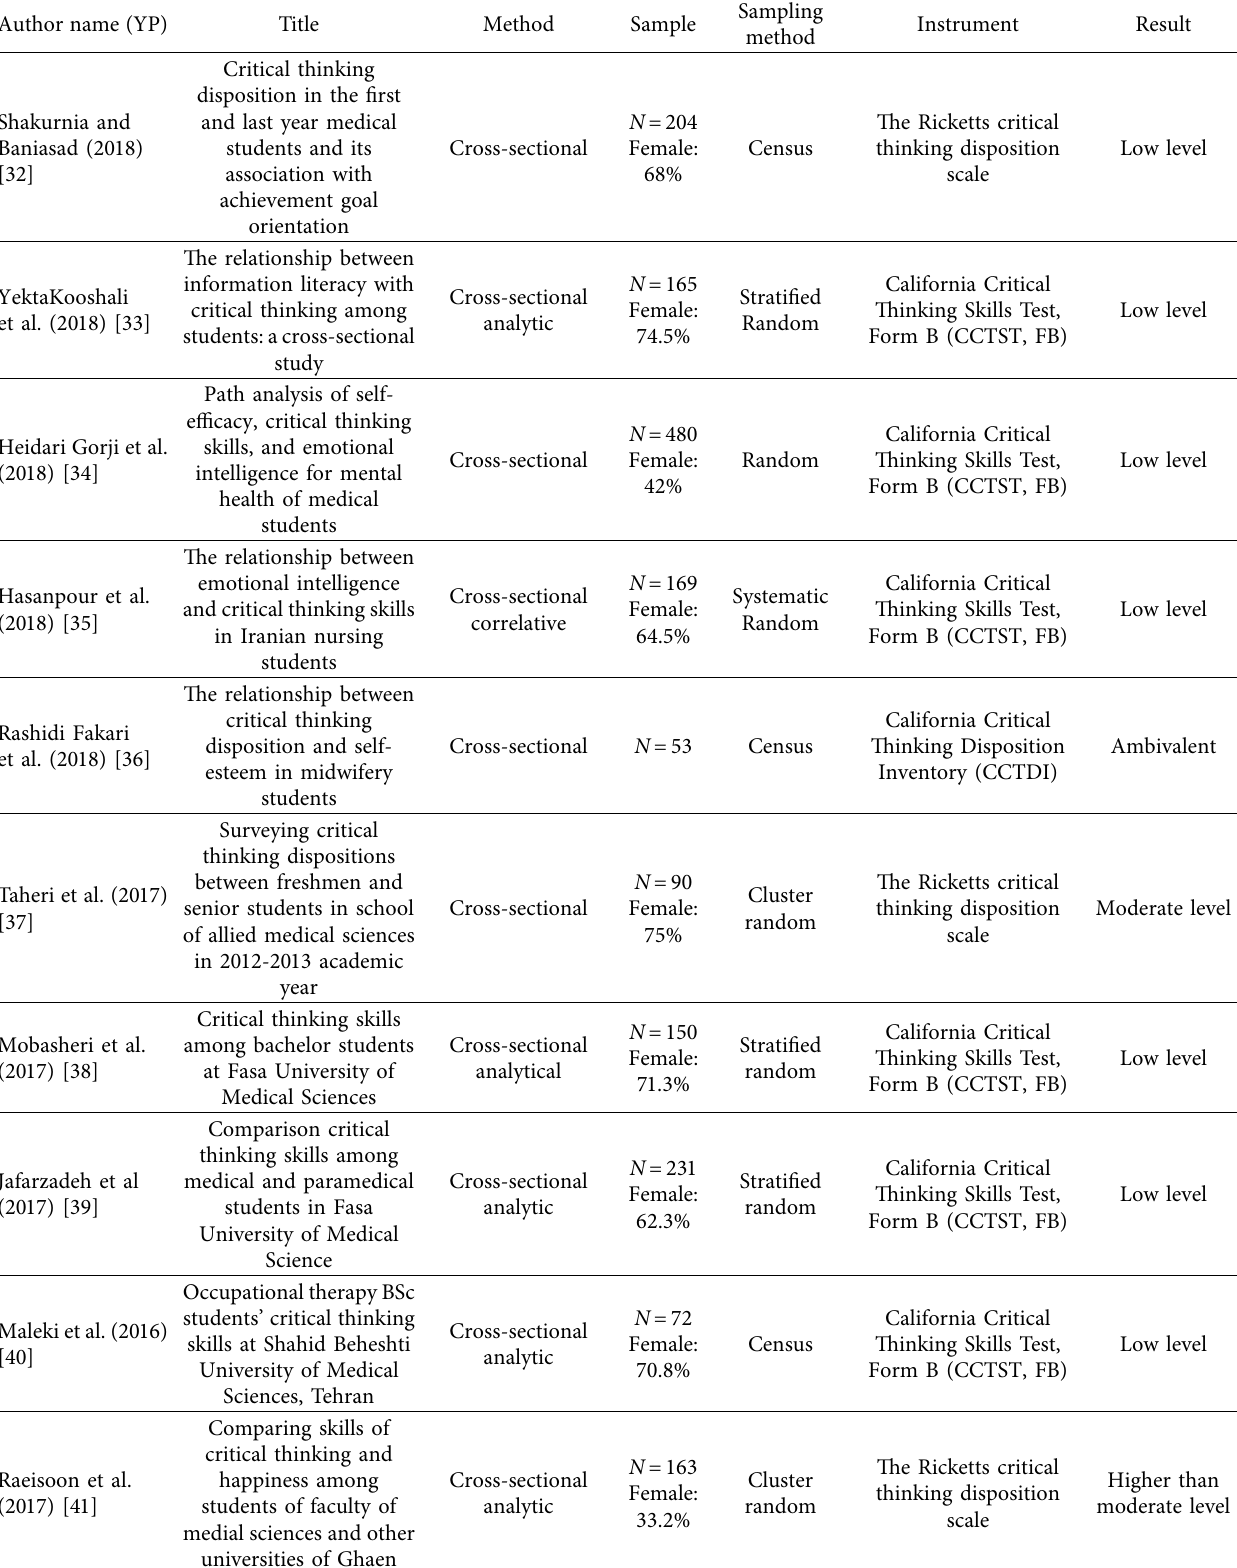
Table 1: Features of the studies reviewed about critical thinking in Iranian medical sciences